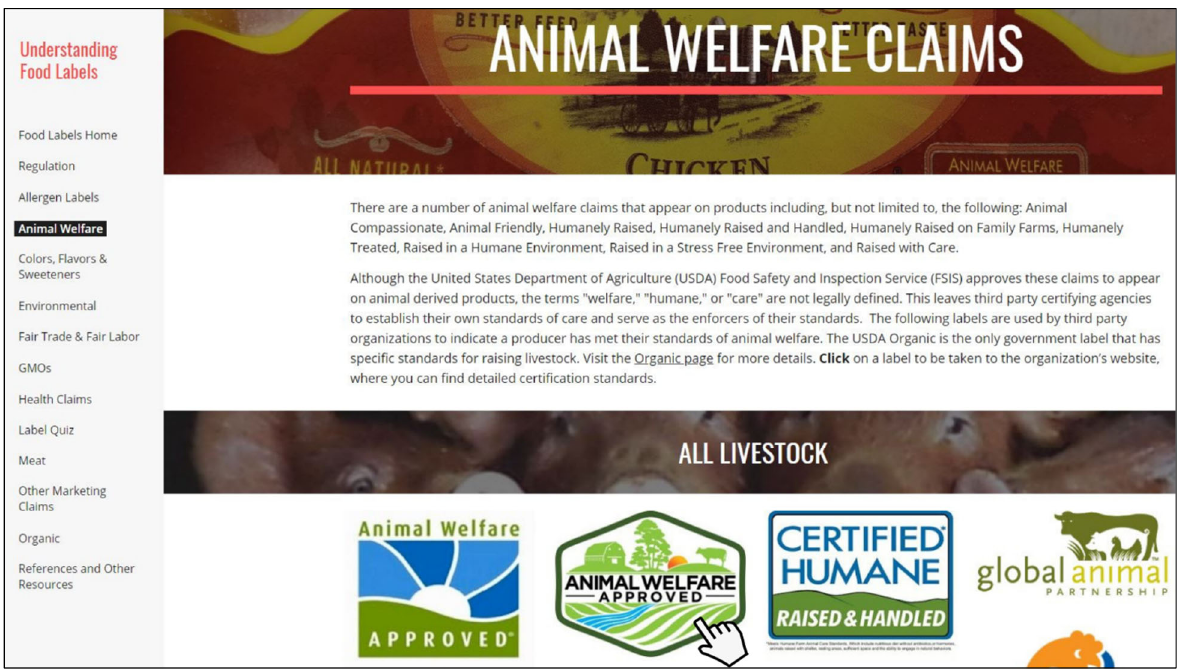
Figure 1. Screenshot of the Animal Welfare Claims Page from the Web